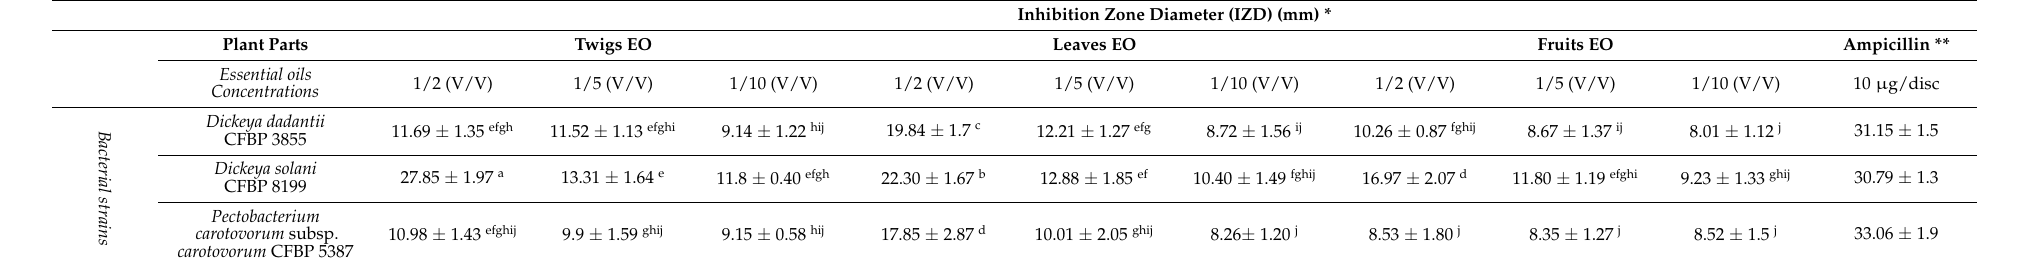
Table 2. Antibacterial activities of Eucalyptus gunnii essential oils and ampicillin as reference antibiotics.